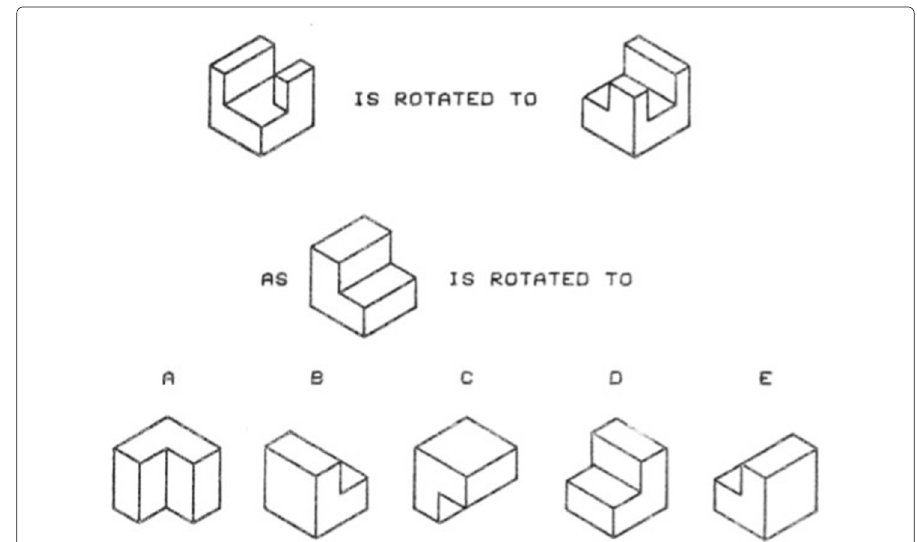
Fig. 2 Example problem in the Rotations section of